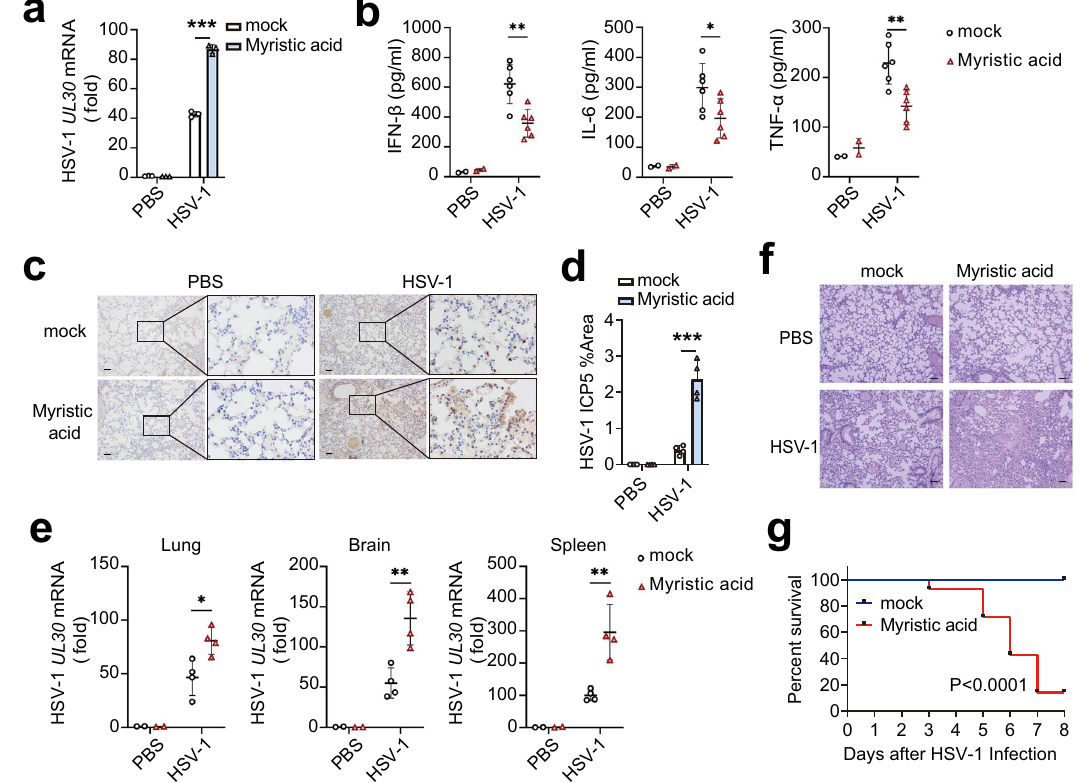
Fig. 2 | Myristic acid inhibits immune responses against HSV-1 in vivo. a Quantitative polymerase chain reaction (qPCR)analysis of HSV-1 UL30 mRNAlevel in peritoneal macrophages (PMs) pretreated with solvent (mock) or myristic acid, and then infected with HSV-1, n =3 samples examined over 3 independent experi- ments. b – g C57BL/6J mice were pretreated with myristic acid, and then infected with HSV-1 (2×10 7 p.f.u. per mouse) by intraperitoneal injection. Serum levels of IFN- β , IL-6, and TFN- α were analyzed by enzyme-linked immunosorbent assay (ELISA) (PBS group, n =2; mock HSV-1 group, n =6) ( b ). Immunohistochemistry (IHC) analysis of HSV-1 protein ICP5. Scale bar, 100 μ m ( c and d ). qPCR analysis